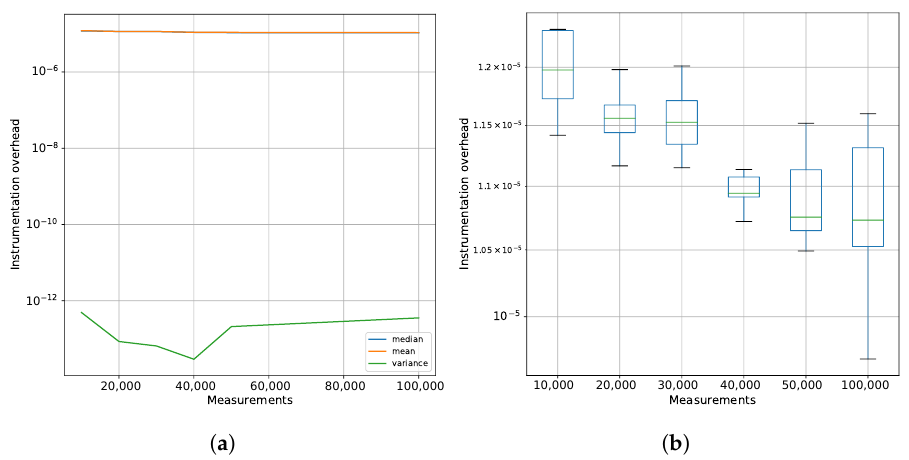
Figure 2. Measuring variance of the time to single instrumentation, i.e., a call to analyzer_start and analyzer_stop while varying the number of measurements. ( a ) Time consumed from sampling a region one time in seconds. ( b ) Box plot showing the statistics of the sampling time of a single region.